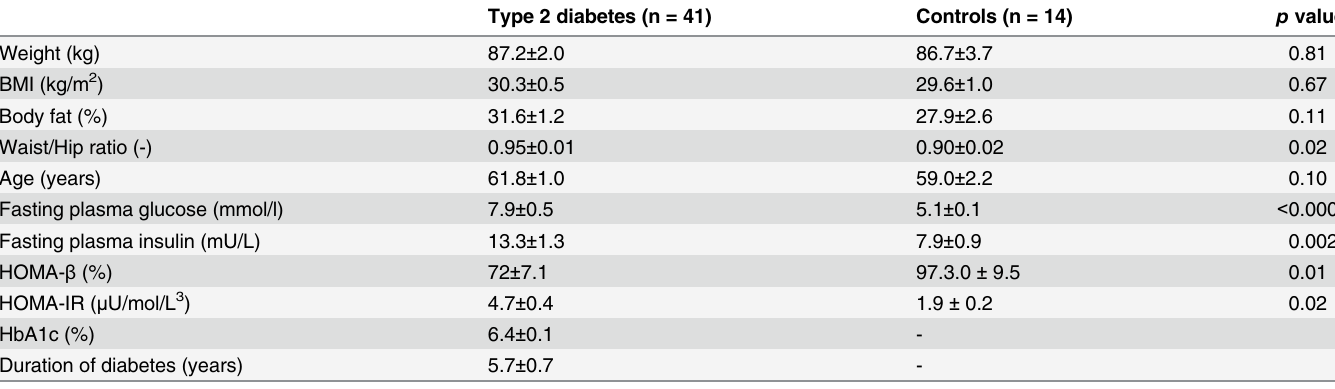
Table 1. Anthropometry and metabolic characteristics of the Type 2 diabetes and Control